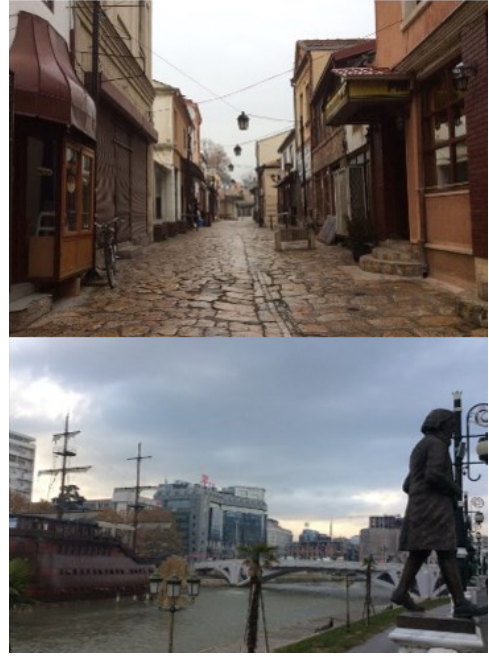
Figure 5 . Different scales of the traditional and contemporary